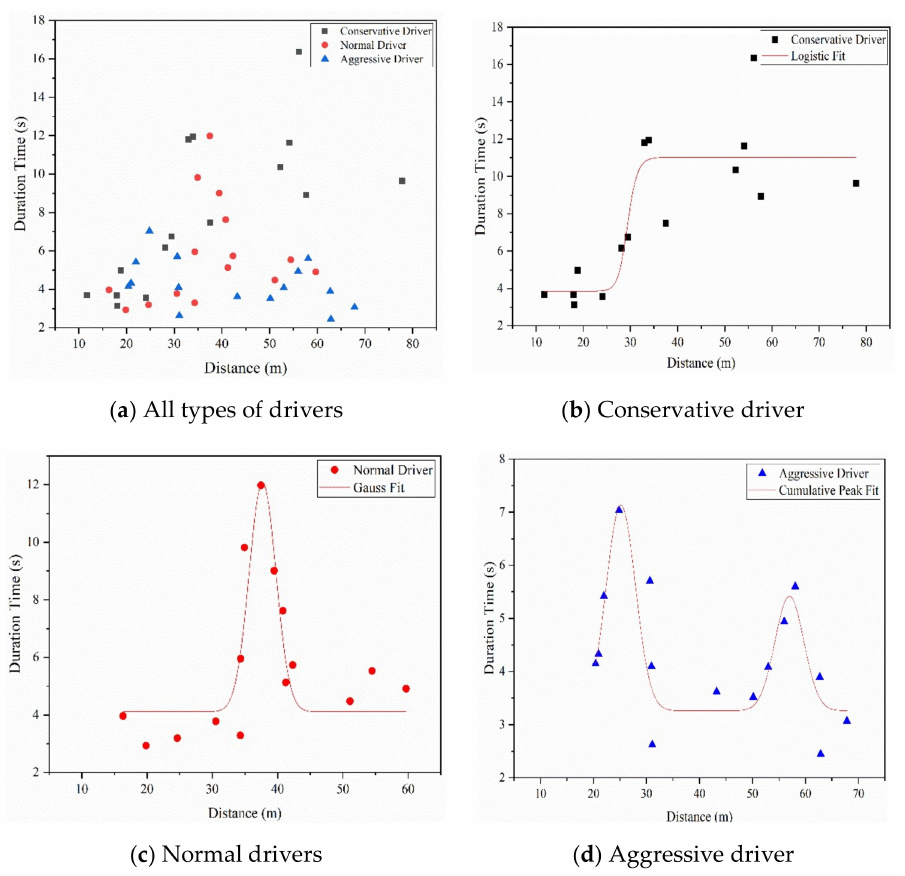
Figure 9. The relationship between lane-change position and